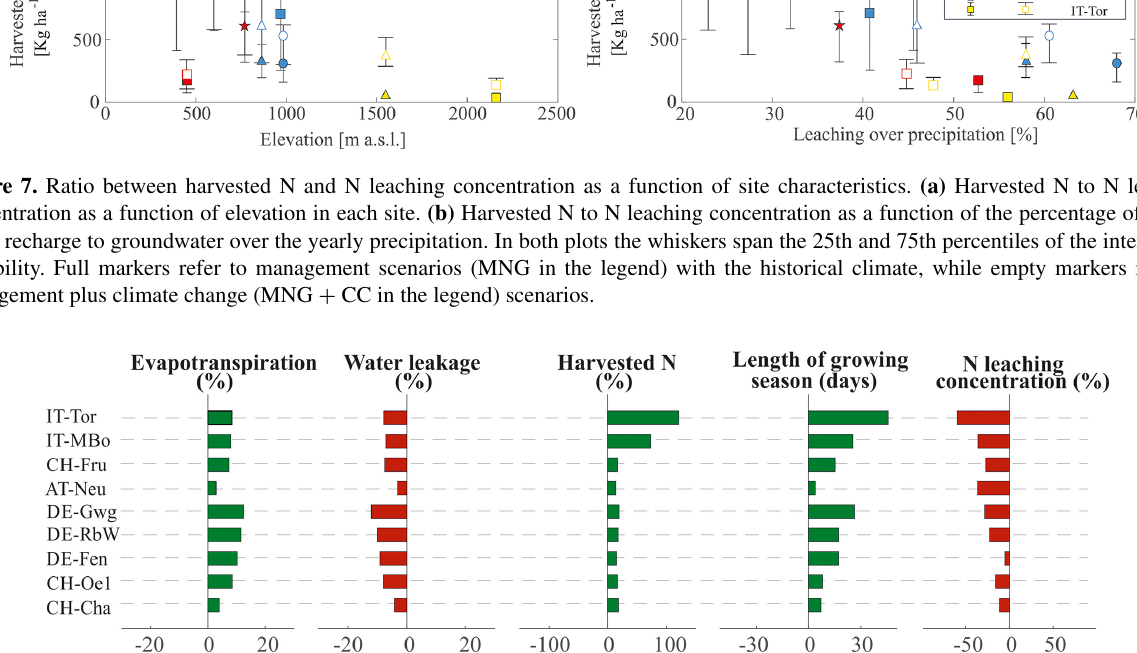
Figure 8. Changes in evapotranspiration, water leakage, harvested N, length of the growing season, and N concentration in leaching under the influence of modified climate ( + 3 ◦ C and + 250ppm). The bar plots indicate the average percentage change of the management scenarios when run under historical and modified climate scenario. The variation in the length of growing season is expressed in days. Red bars refer to a decrease in the variable under modified climate, while green bars represent an